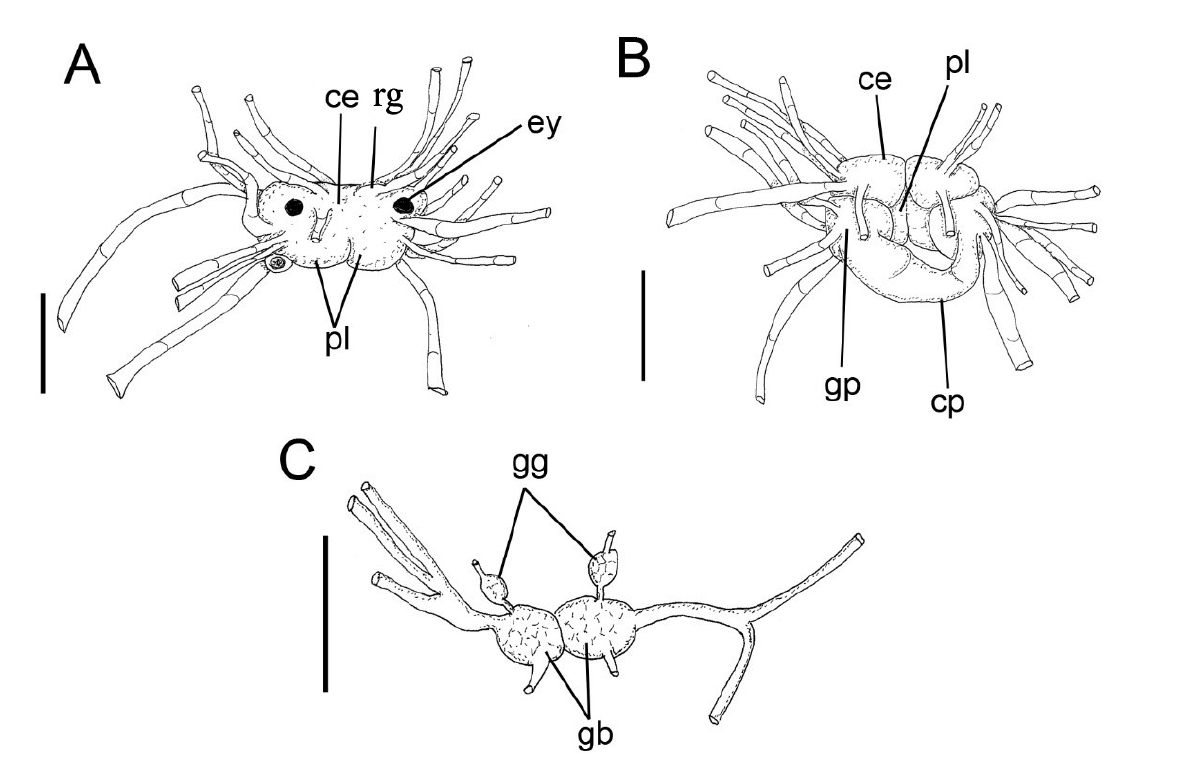
Figure 5. Platydoris angustipes . Nervous system A dorsal view B same, ventral view C buccal and gastroesophageal ganglia. Scale bars: 1